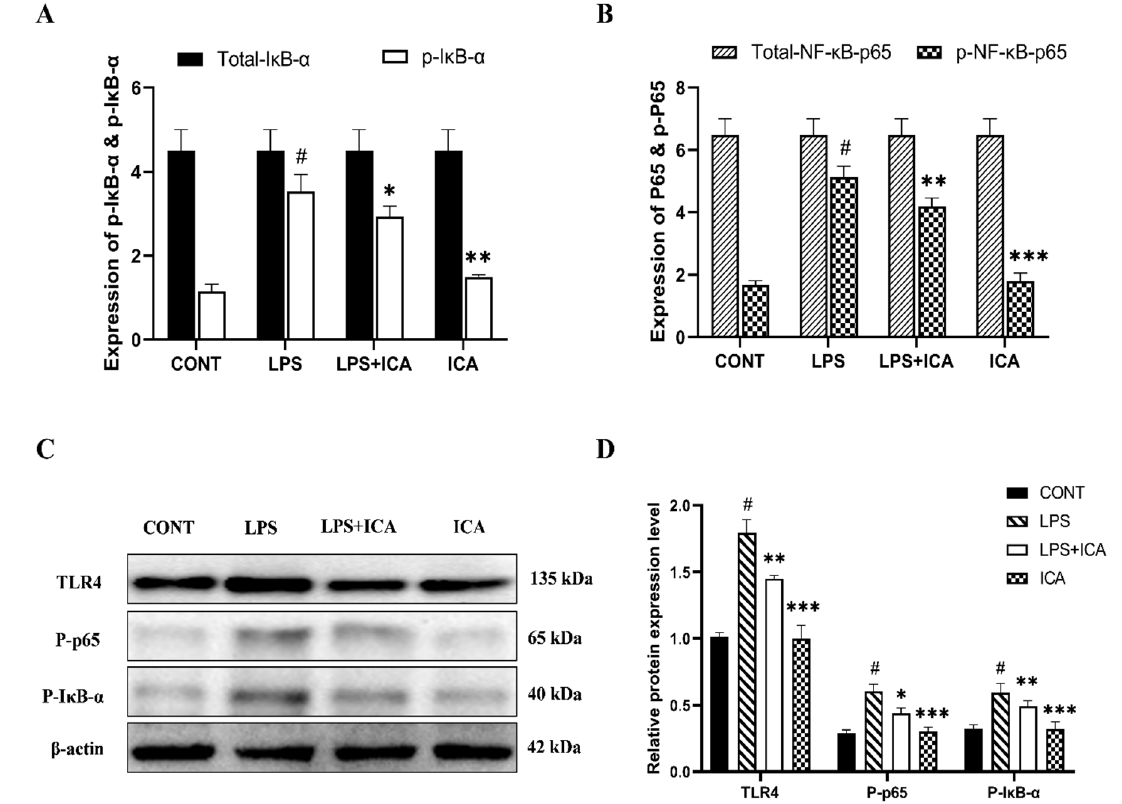
Figure 5. Outcomes of ICA in LPS-induced expression NF- κ B signaling pathway. ( A ) The expression levels of the NF- κ B-p65 and its phosphorylated (p-NF- κ B-p65) form were detected by ELISA. ( B ) The expression levels of total I κ B α and its phosphorylated (p-I κ B α ) form were detected by ELISA. ( C ) The protein expression levels of the TLR4, phosphorylated (p-NF- κ B-p65), and phosphorylated (p-I κ B α ) were detected by western blotting. ( D ) The quantification of all the analyzed proteins. The β -Actin was used as a control. The data were statistically presented as means ± SEM. The # p < 0.001 between CONT and LPS groups, and * p < 0.05, ** p < 0.01, *** p < 0.001 between LPS and ICA therapy groups. (CONT, LPS, and ICA stand for control, lipopolysaccharide, and Icariin groups [The ICA dose used was 50 mg/kg for uterine tissue]).